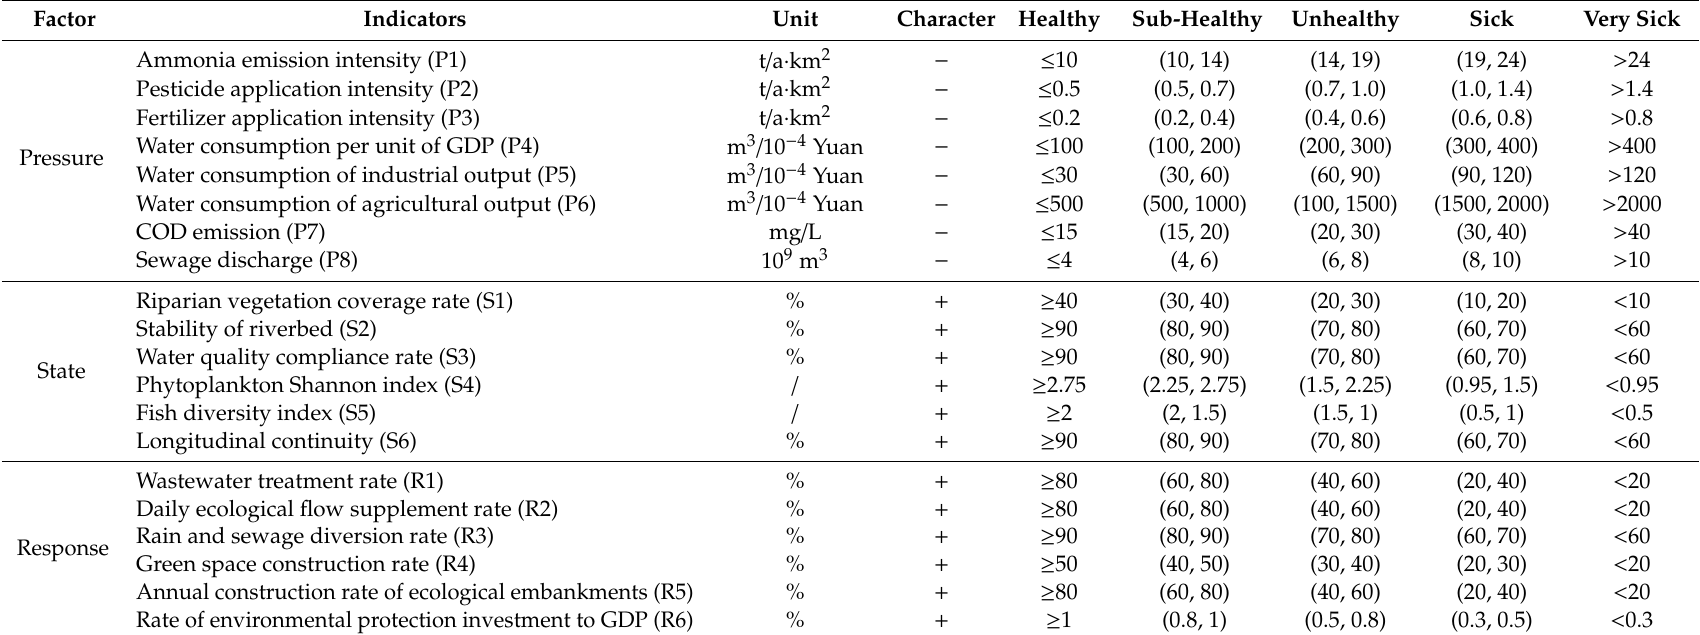
Table 2. Health grade standard for the evaluation